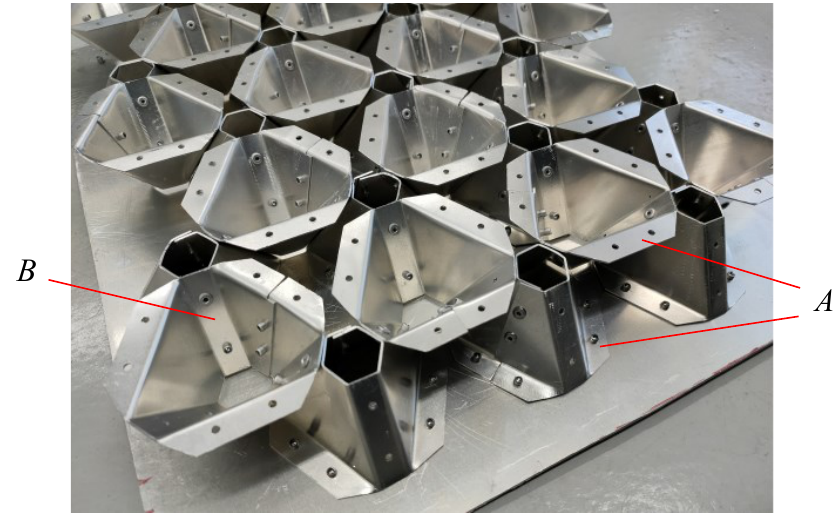
Figure 17. Joints between truss cores and joints between truss core and face plate.